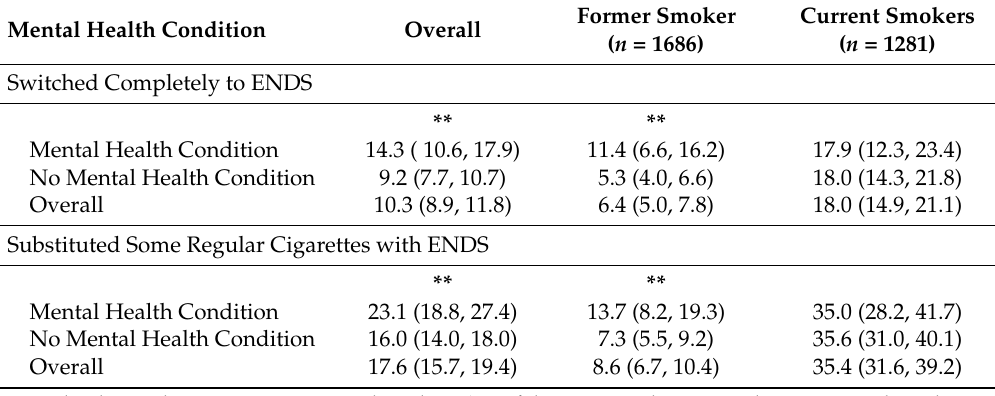
Table 5. Prevalence of ENDS use as a quit method by lifetime mental health condition and smoking